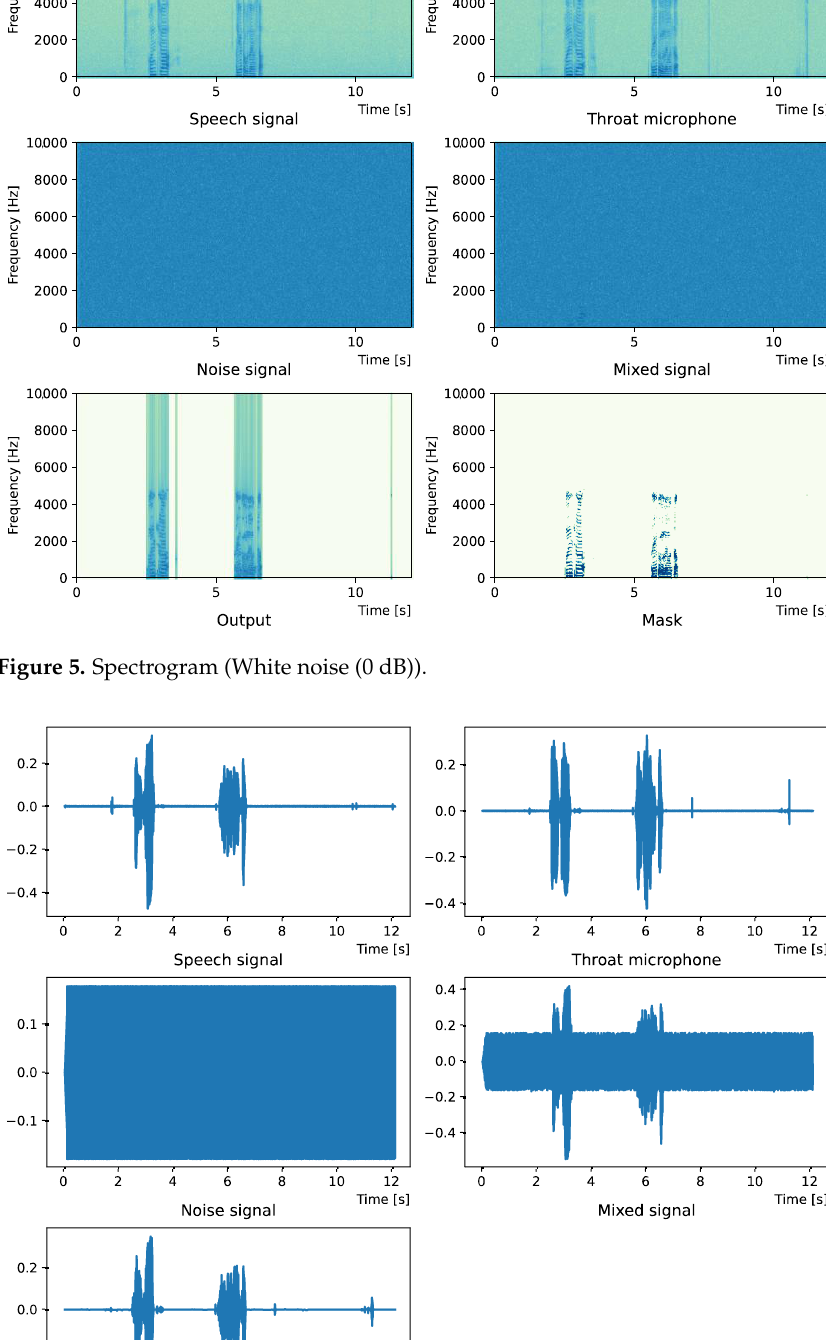
Figure 4. Waveform (White noise (0 dB)).